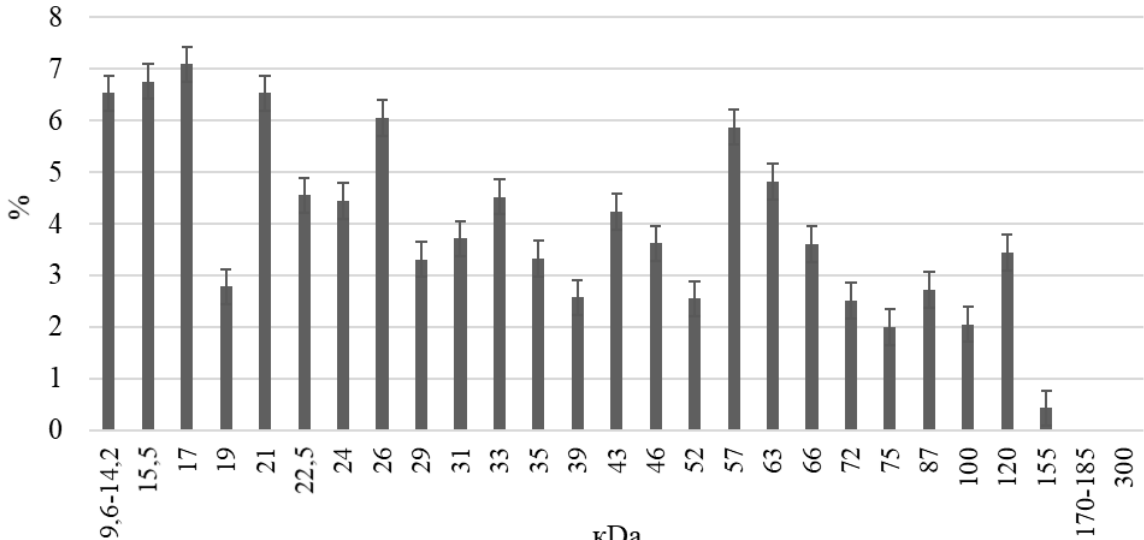
Fig. 6. Structural proteins of the basolateral membrane of the jejunum enterocytes of the four-month old cattle fetus (M ± m; %; n =